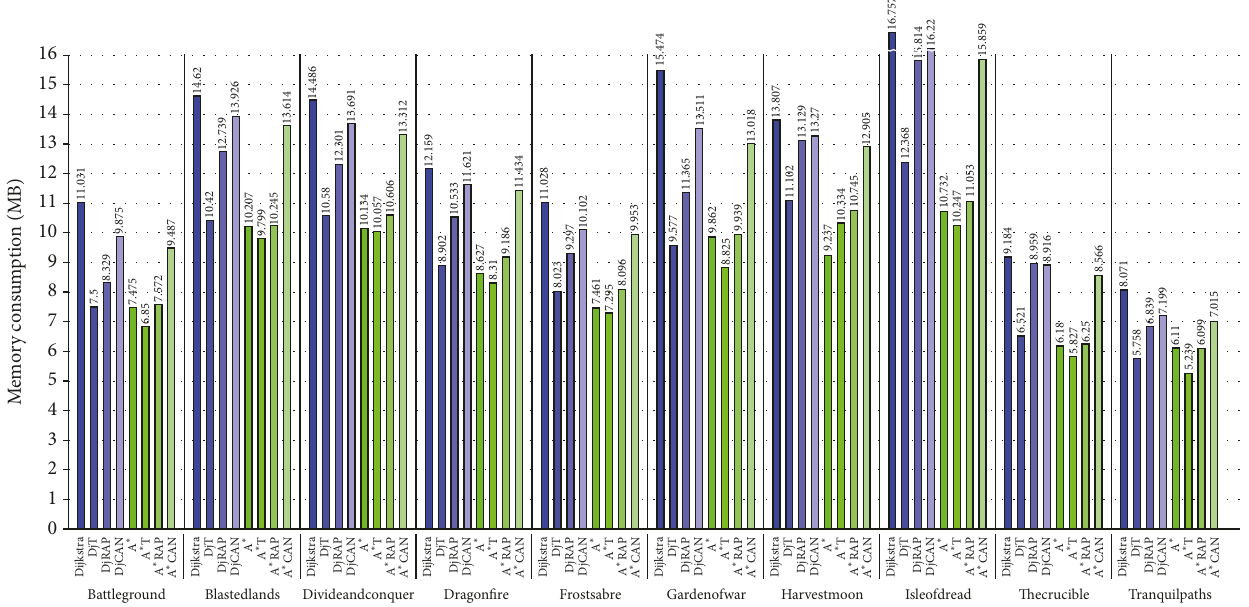
Figure 12: Memory space consumption for 10 maps of Warcraft III